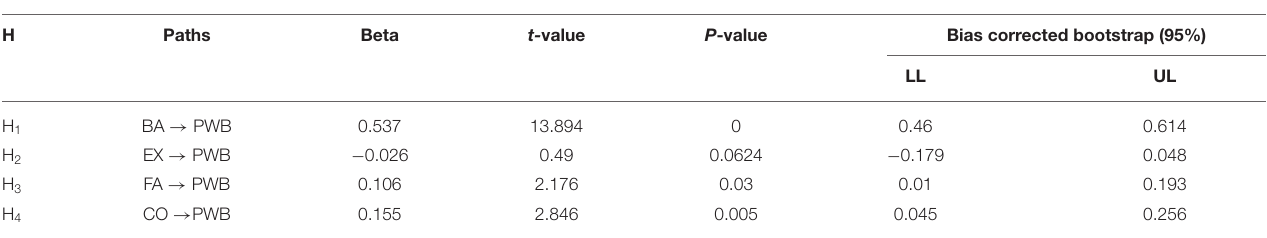
TABLE 4 | Structural model